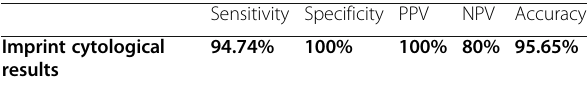
Table 7 Receiver operating characteristic (ROC) curve of imprint cytological results in the thoracoscopic